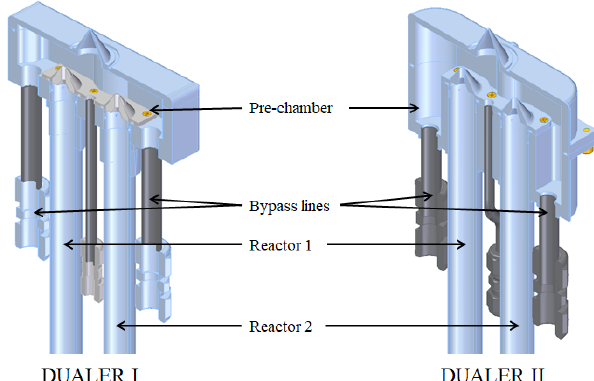
Figure 2. Graphical 3D representation of the upper part of the DUALER I and DUALER II inlets. Pre-chamber volume DUALER I is 75.25cm 3 ; reactor volume DUALER I is 112cm 3 ; pre-chamber volume DUALER II is 119.57cm 3 ; reactor volume DUALER II is 130.5cm 3